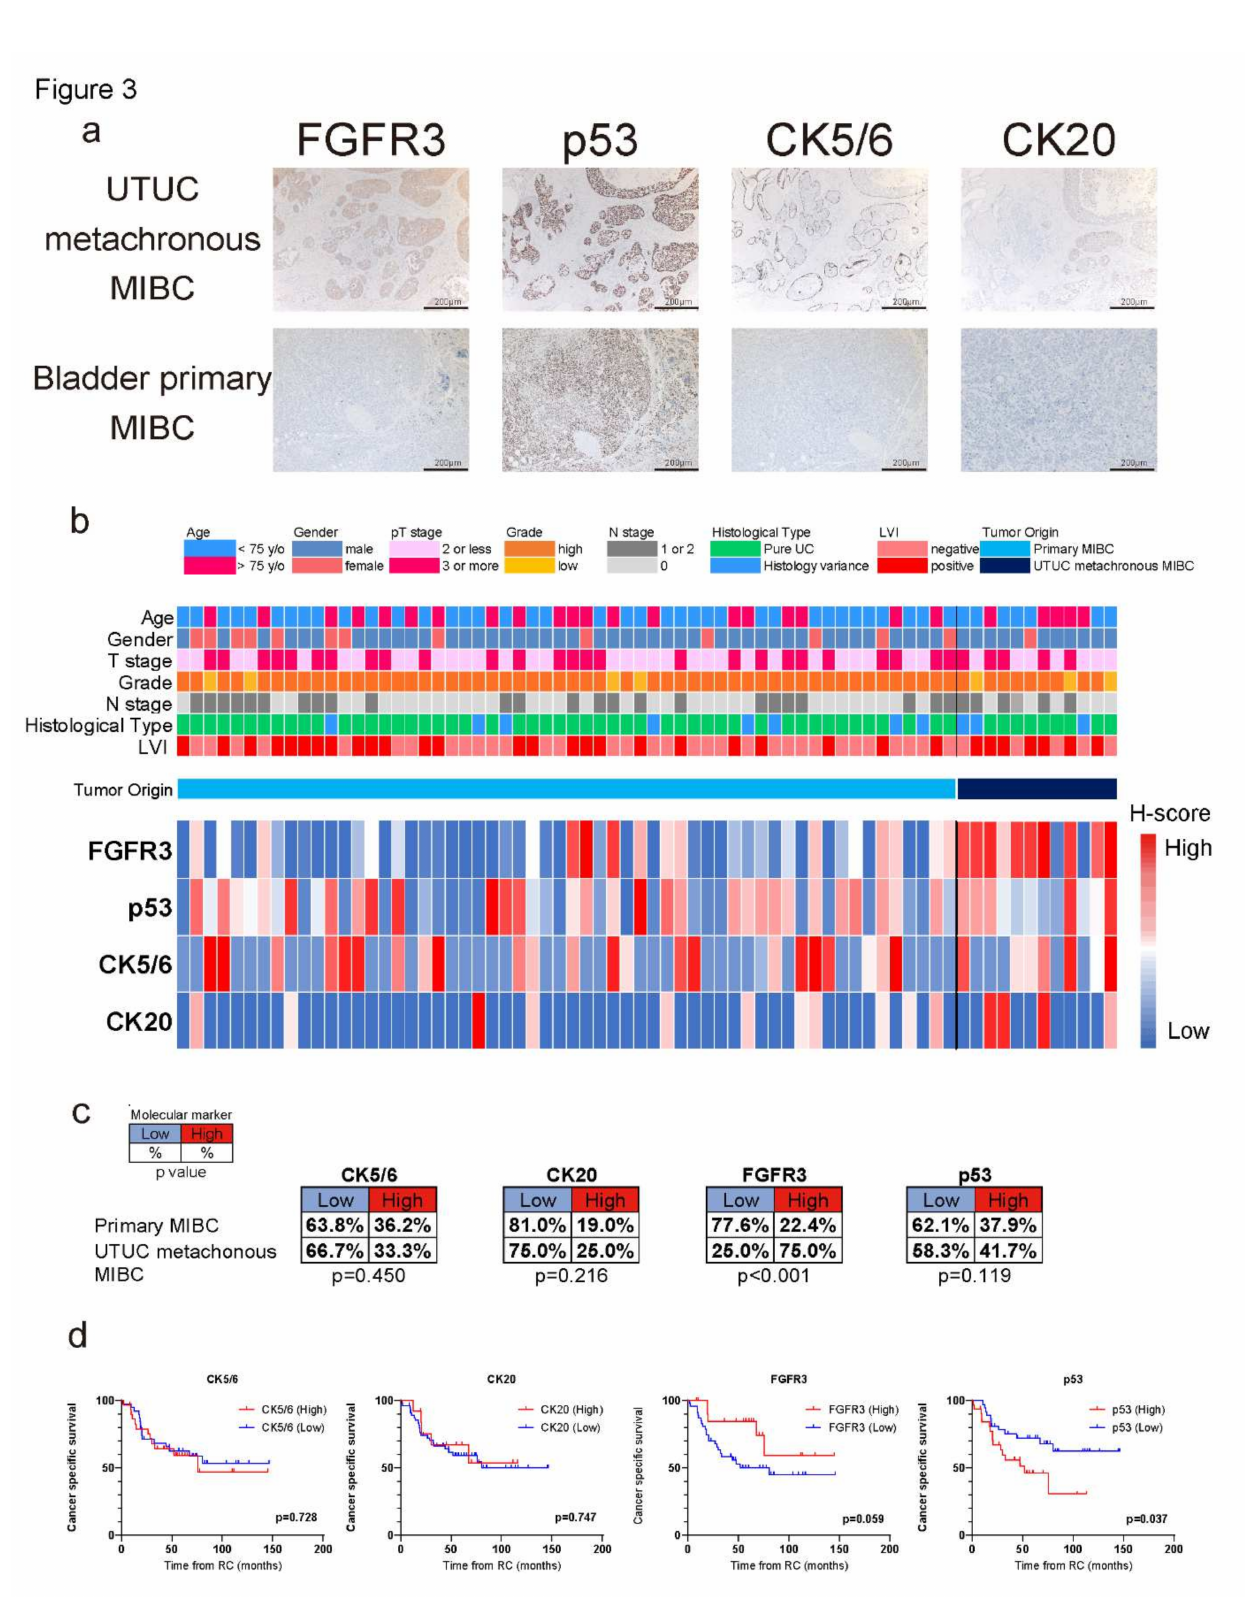
Figure 3. ( a ) Representative IHC staining of FGFR3, p53, CK5/6, and CK20 in surgical specimens after radical cystectomy (RC). pT2 UTUC metachronous MIBC and pT2 bladder primary MIBC are shown. Power field scale bar = 200 µ m. ( b ) Heatmap describing the IHC score of each molecular marker in MIBC patients who underwent RC ( n = 70). The heatmap of MIBC patients is classified by UTUC metachronous or bladder primary MIBC with information for age, sex, pT stage,